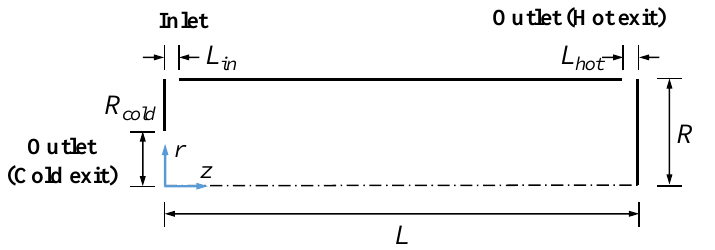
Figure 1. Schematic of the computational domain for axisymmetric swirl flow.